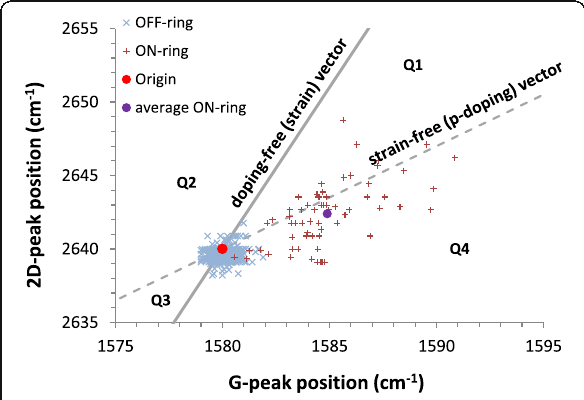
Fig. 5 G-2D correlation plot showing data for three line-scan measure- ments across the graphene-integrated MRR. The red crosses are points taken where the graphene sits ON the MRR structure with the purple dot representing the average of these coordinate values and the blue crosses where the graphene is suspended across the MRR (OFF the underlying structure). The red dot is the unstrained, intrinsic coordinate value for graphene with 633-nm laser excitation, which defines the origin. The dashed line denotes the strain-free ( p -doping) vector with Δ ω Δ ω 2D / G ~0.7, and the solid line denotes the doping-free (strain) vec- tor with Δ ω 2D / Δ ω G ~2.2, after